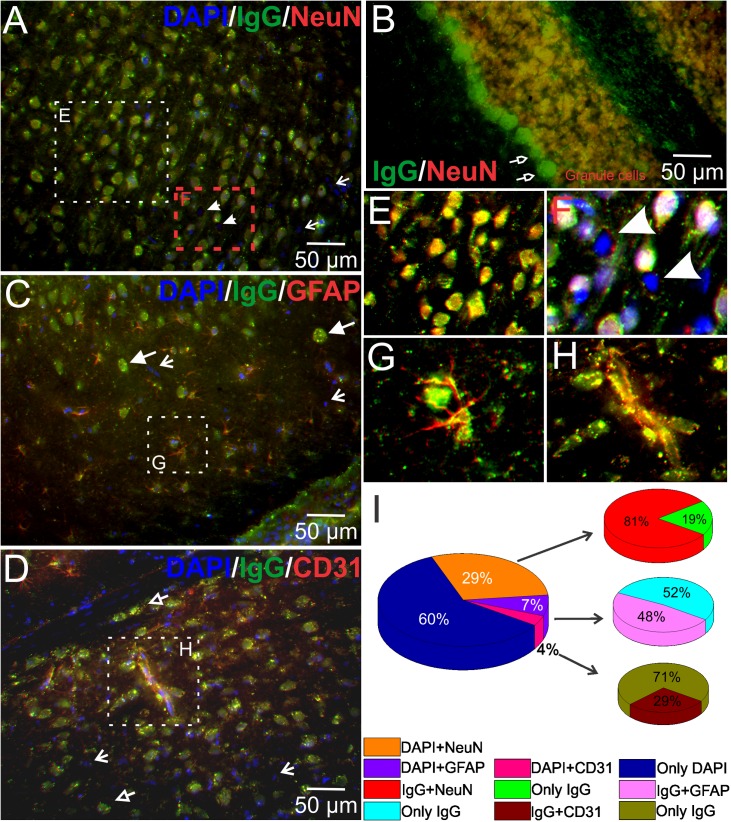
Autoantibodies are primarily directed against neuronal antigens.The figures show co-localization of cancer-derived autoreactive immunoglobulins (green) and neuronal (NeuN, red), astrocytic (GFAP, red), and endothelial (CD31, red) markers. Immunoreactivity for serum IgGs demonstrated staining of most cortical (A) and cerebellar (B) neurons. Small areas of ‘A’ were expanded in ‘E’ (cancer-IgG and anti-NeuN) and ‘F’. Some neurons were neither positive for cancer-IgG nor for anti-NeuN antibody (F, arrowheads). Purkinje cells were negative for NeuN (B, open arrows), nonetheless both Purkinje and granule cells immunoreacted with sera IgGs (B). A few IgG positive cells were defined as astrocytes (C) and endothelial cells (D). Small areas of ‘C’ and ‘D’ without DAPI staining were magnified to ‘G’ and ‘H’, respectively. The content of IgG in astrocytes was limited to the cytosol and to a few processes. The majority of cells in these panels were positive for cancer-IgGs (C, triangle arrows point; D, open triangle arrows point; green). A small percentage of cells remained unstained for IgGs (A, C, & D, simple arrows). I) Quantification of IgGs and cell-specific proteins in cortex. 81% of neurons were co-stained with cancer-derived IgG while 48% and 29% of astrocytes (by GFAP) and endothelial cells (CD31) were co-localized with cancer-IgG, respectively. NeuN, neuronal nuclei; GFAP, glial fibrillary acidic protein; CD31, cluster of differentiation 31.